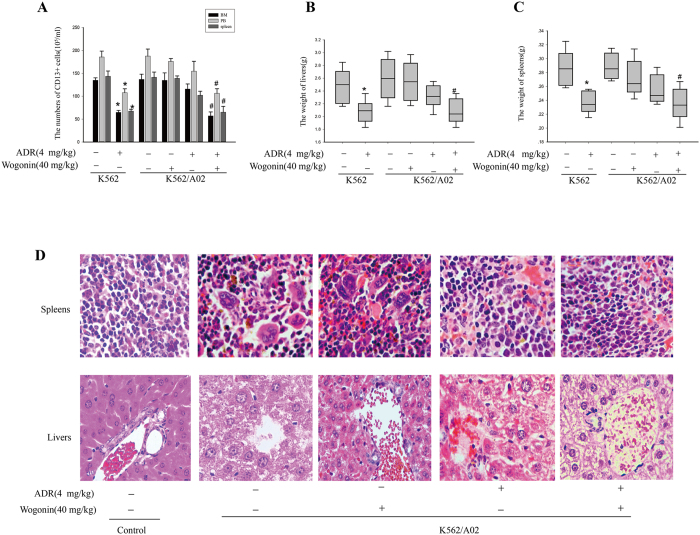
Wogonin potentiated the inhibitory effect of ADR on tumor growth in NOD/SCID mice.Tumor xenografts inoculated with K562 and K562/A02 cells (resistance group). Then the transplanted animals were treated with ADR (4 mg/kg) by intravenous injection two times a week; Wogonin (40 mg/kg) intravenous injection was performed every other day for 4 weeks. (A) CD13+ cells of BM, PB and spleen were detected by flow cytometry. *p < 0.05 versus untreated K562 group. #p < 0.05 compared with untreated K562/A02 group. (B,C) The weight of livers and spleens was analysis. *p < 0.05 versus untreated K562 group. #p < 0.05 compared with untreated K562/A02 group. (D) The spleens and livers were examined for H&E staining. All results were represented as the mean ± SD of three independent experiments.